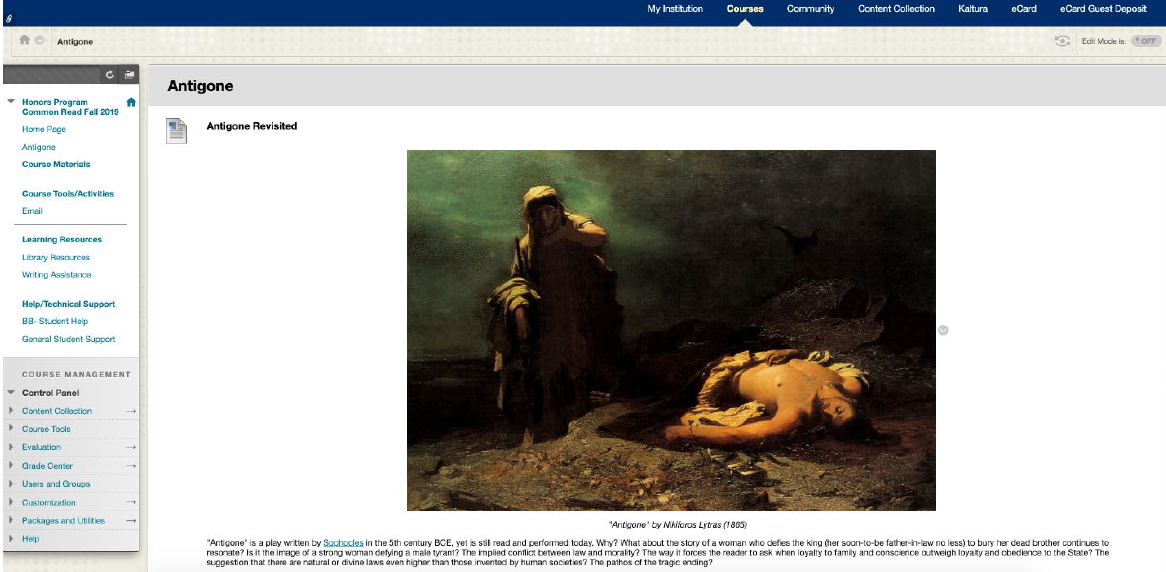
Figure 4. Landing Page in Blackboard for 2019 Honors Program Common